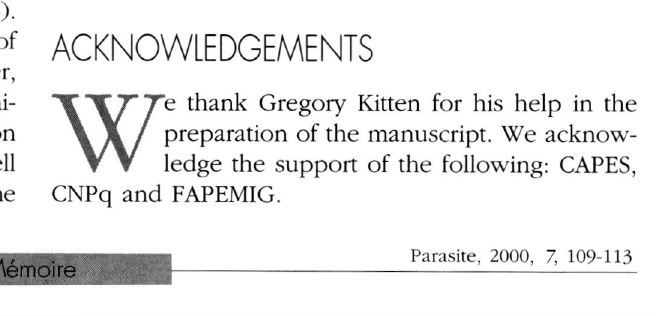
similar to those observed on the rat parotid gland after orchiectomy (Jezek et al,